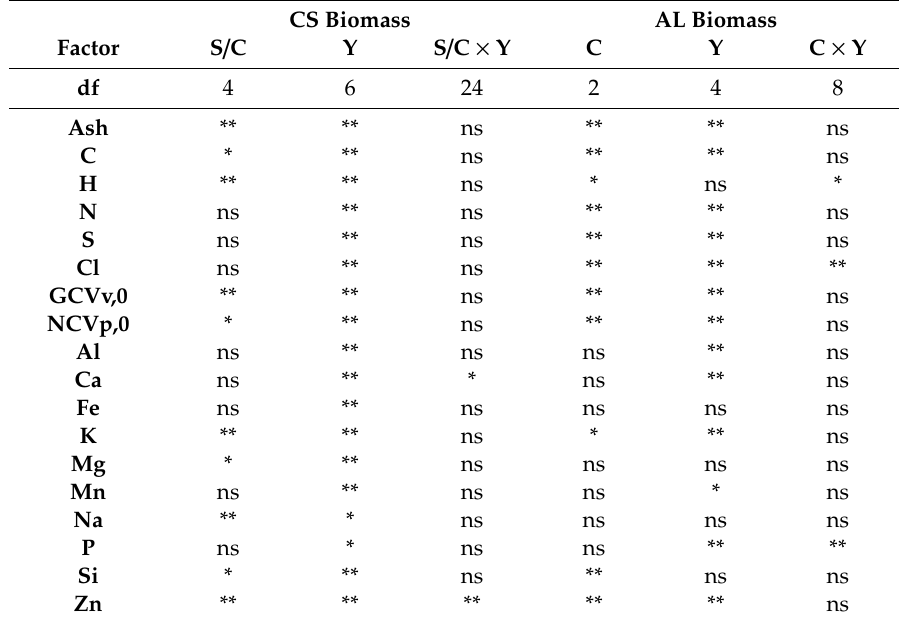
Table 5. Influence of the di ff erent species, cultivars, and years on the biomass properties and chemical composition of the biomass cultivated at two locations (CS and